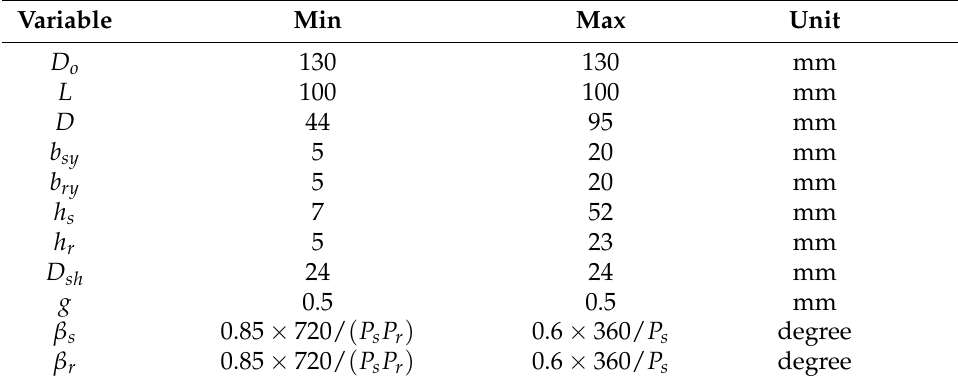
Table 2. Limits of